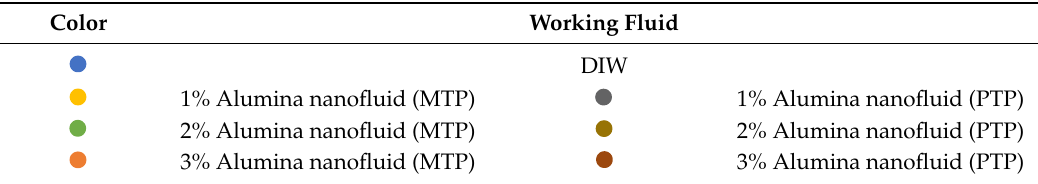
Table 3. Colors for working fluids.